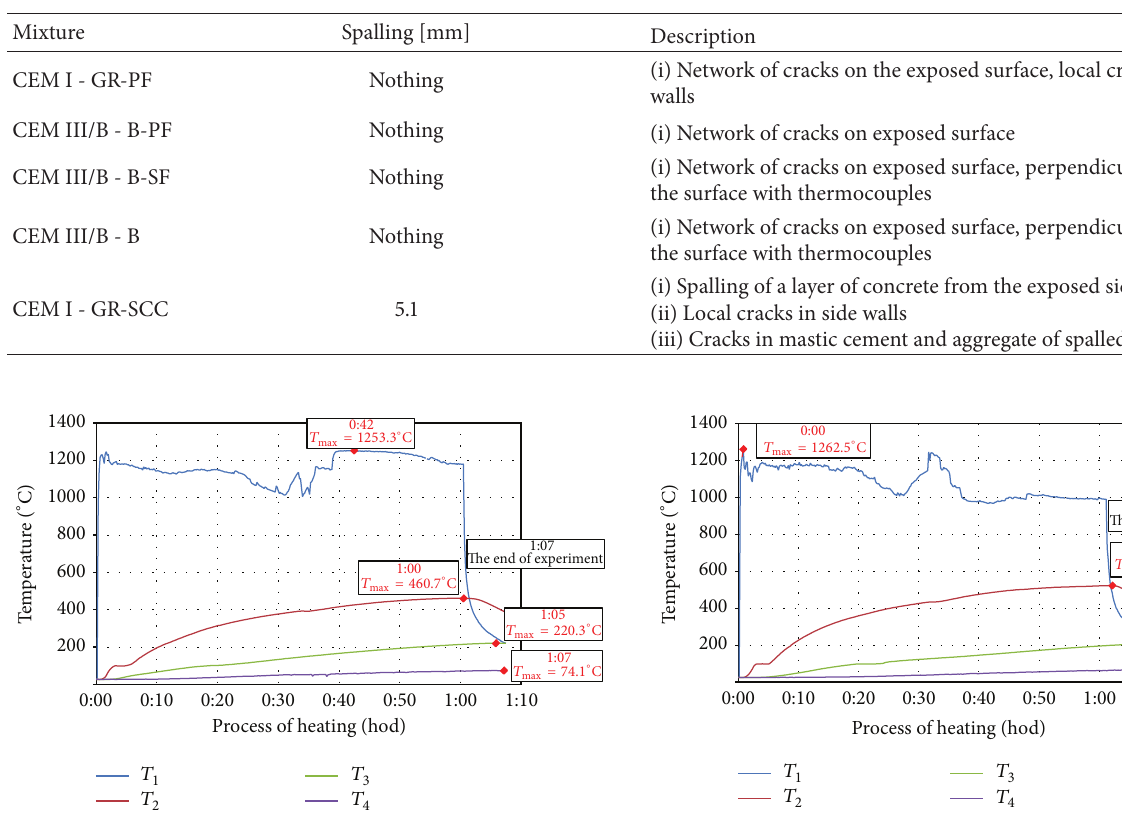
Figure 2: Record of thermal development of the test specimen CEM I - GR-PF.